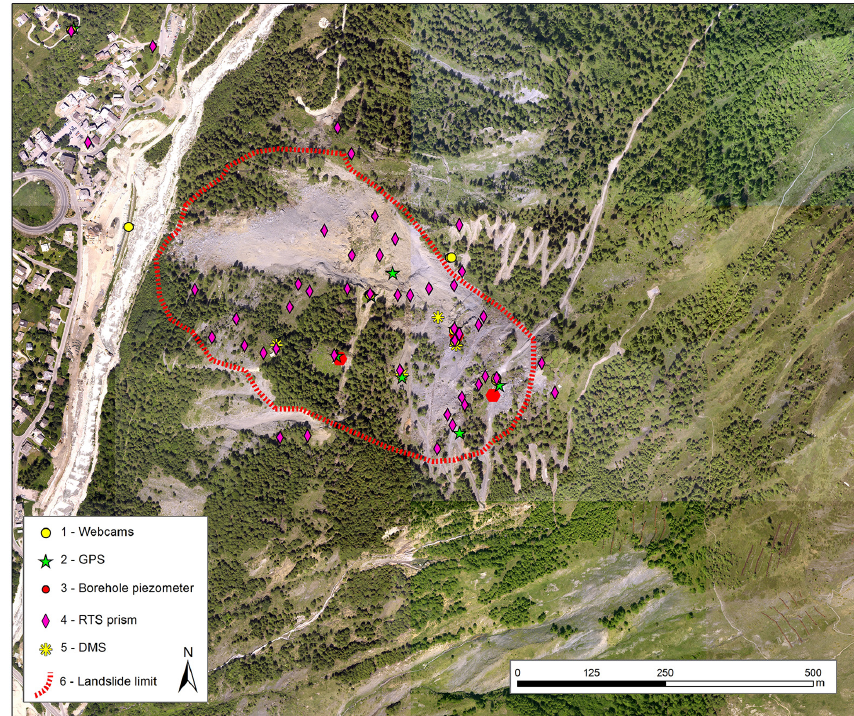
Figure 1. La Saxe intensive monitoring network composed of: (1) webcams; (2) GPS devices; (3) borehole piezometers; (4) Robotic Total Station network (surveying 36 optical targets), (5) DMS TM columns (Lovisolo et al., 2003; Blikra et al., 2013) and (6) limit of the unstable area.